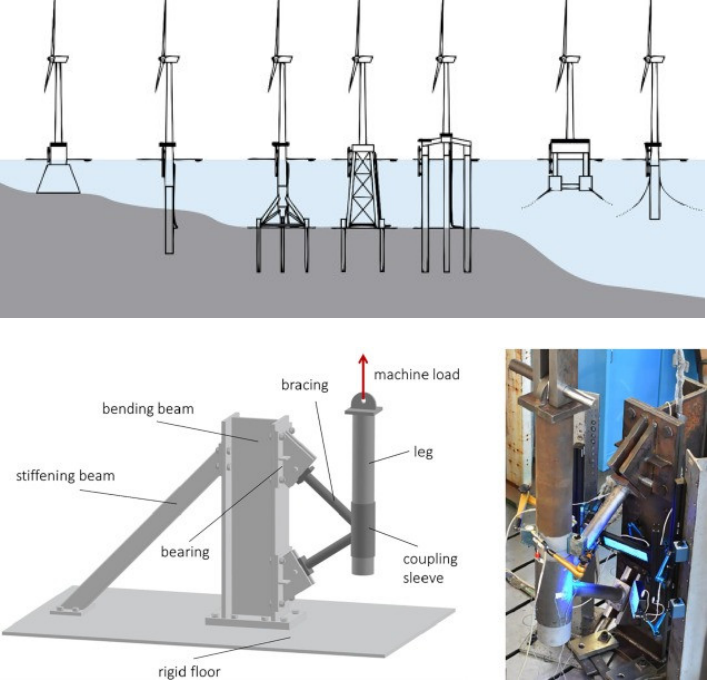
Figure 6. Large-scale detail of hybrid tubular joints for offshore wind turbine investigated in [12]. Reprinted with permission from ref. [12]. Copyright 2022 Elsevier.